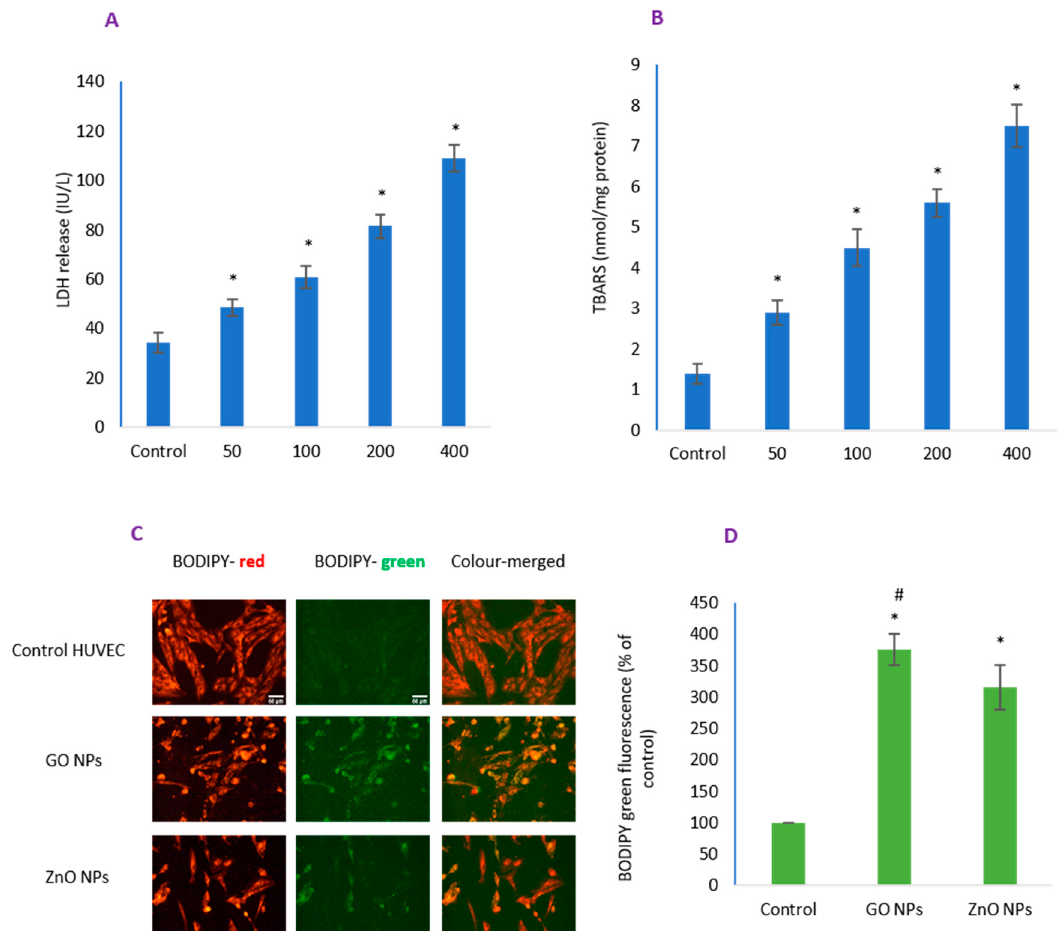
Figure 3. Potential loss of membrane integrity in HUVEC cells due to GO NPs were revealed by ( A ) quantifying LDH release in culture media, ( B ) peroxidation in lipid bilayers poly unsaturated fatty acids, followed by ( C ) imaging of membrane residing BODIPY probe; ( D ) BODIPY CTCF of only green fluorescence is given, as it is the indicator of lipid peroxidation (LPO) while red fluorescence is uniform in control and treated cells. Scale bar represents 50 µm in each image (20× objective). * Statistically significant difference than the controls ( p < 0.05). #—Significantly high BODIPY fluorescence due to GO NPs compared to ZnO NPs ( p < 0.05).